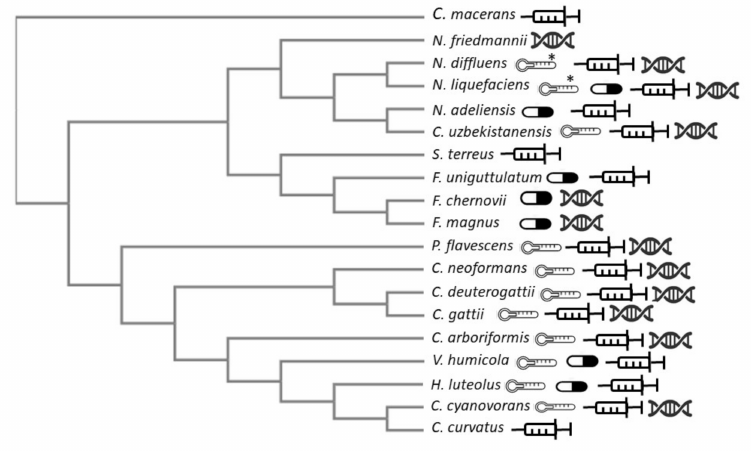
Figure 2. Neighbor-joining tree without distance corrections obtained using the clustal omega tool (https://www.ebi.ac.uk/). The following Genebank LSU D1/D2 sequences were used: FJ534907 ( Cryptococcus deuterogattii CBS 10514T), AF075526 ( Cryptococcus gattii CBS 6289T), FJ534909.1 ( Cryp- tococcus neoformans CBS 8710), AB260936 ( Cutaneotrichosporon arboriformis CBS 10441T), AF189834 ( Cutaneotrichosporon curvatus CBS 570T), JF680899 ( Cutaneotrichosporon cyanovorans CBS 11948T), NG_059011.1 ( Cystofilobasidium macerans CBS 10757T), AF181530 ( Filobasidium chernovii CBS 8679T), AF181851 ( Filobasidium magnum CBS 140T), AF075468 ( Filobasidium uniguttulatum CBS 1730T), AF075482 ( Hannaella luteola/luteolus CBS 943T), AF137603.1 ( Naganishia adeliensis CBS 8351T), AF075502 ( Naganishia diffluens CBS 160T), AF075478 ( Naganishia friedmannii CBS 7160T), AF181515 ( Naganishia liquefaciens CBS 968T), AF181508 ( Naganishia uzbekistanensis CBS 8683T), AB035042 ( Papil- iotrema flavescens CBS 942T), AF075479 ( Solicoccozyma terreus CBS 1895T), AF189836 ( Vanrija humicola CBS 571T). The thermometer graphic represents the species able to grow at 37 ◦ C. * represent poor growth at 37 ◦ C. Pill graphics show species with the highest fluconazole MIC (>16 ug/mL). Syringe graphs show species isolated from normally sterile sites. Double strand graphs show the species identified by molecular-based